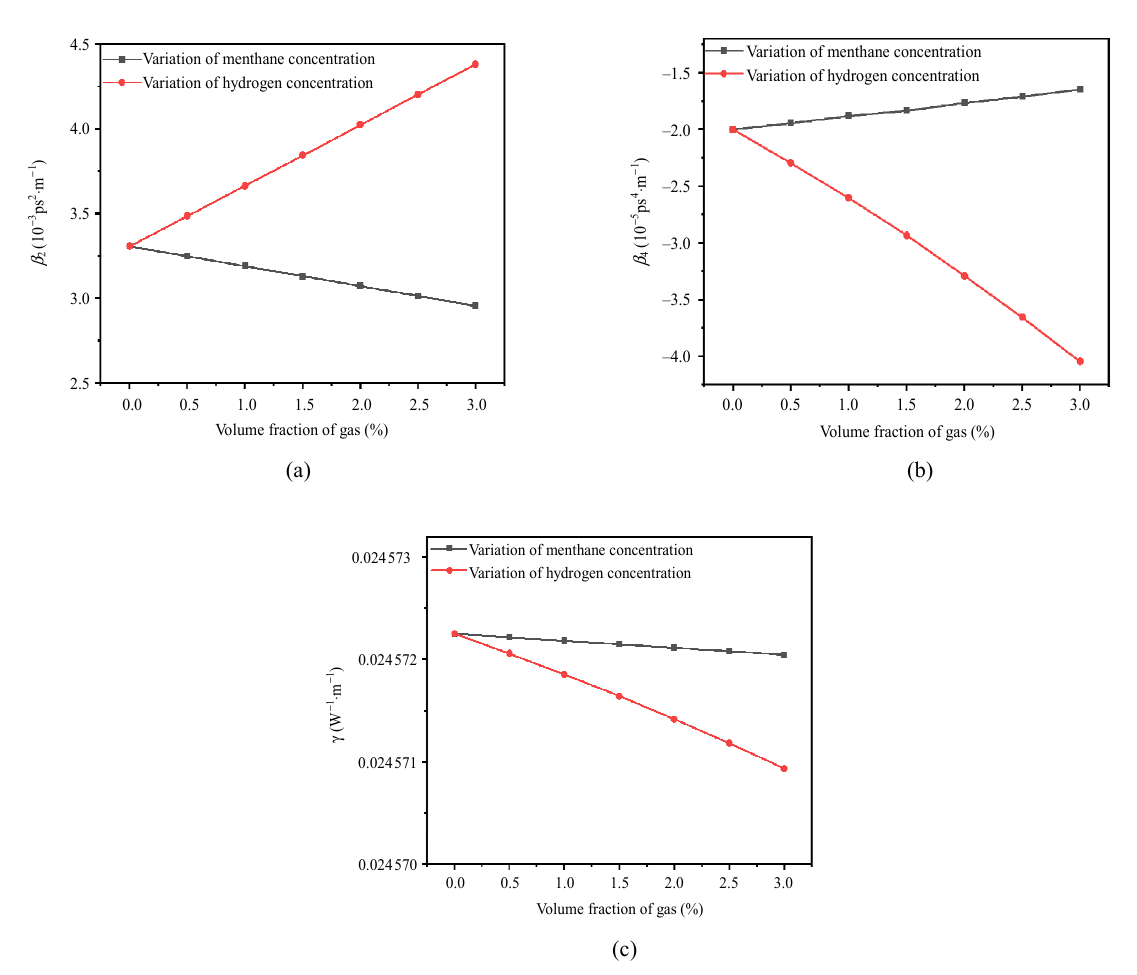
β , (b) β , and (c) γ with the gas 2 4